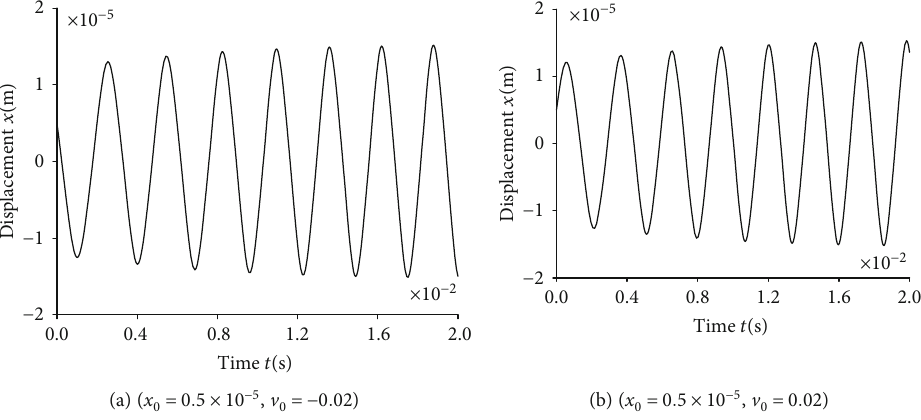
= 1 : 8A , q = 1 : 6 × 10 − 4 m 3 /s 0 0